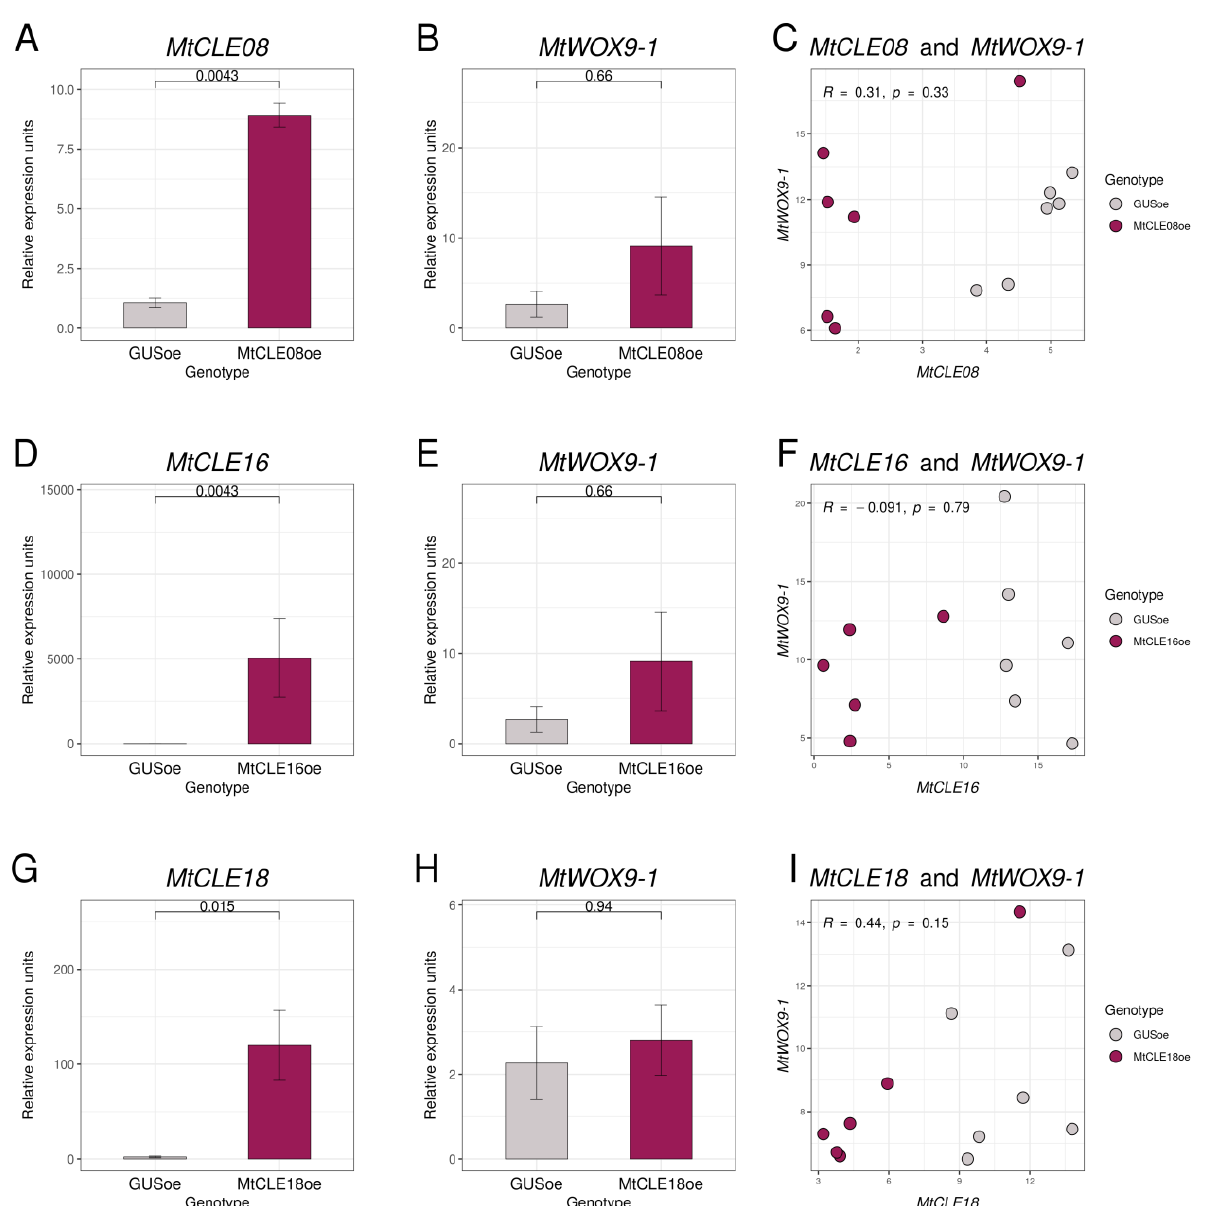
Figure 5. Expression levels of MtCLE08 ( A ), MtCLE16 ( D ), MtCLE18 ( G ), and MtWOX9-1 ( B , E , H ) genes in transgenic calli with GUS and MtCLE08 ( A , B ), MtCLE16 ( D , E ), or MtCLE18 ( F , G ) overexpression. Expression levels of the MtCLE08 ( C ), MtCLE16 ( F ), or MtCLE18 ( I ) gene and the MtWOX9-1 gene in individual callus samples. Error bars represent the standard error. Data are obtained from six biological repeats per genotype. To assess the statistical significance of the observed differences between different genotypes of calli, the Wilcoxon signed-rank test was used. To assess the statistical significance of correlation between expression levels of different genes, Spearman’s rank correlation test was used. Material for gene expression analysis in T0 calli was taken at 43rd–56th day after transformation, after 33–50 days of cultivation on the callus induction medium, and 7–14 days of cultivation on the hormone-free medium.